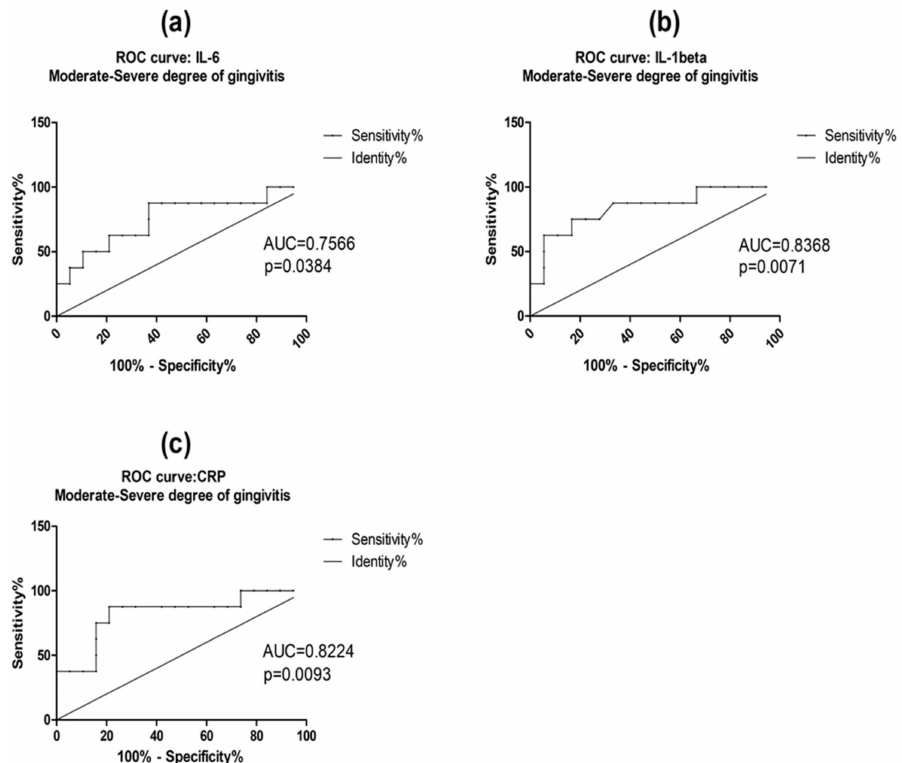
Figure 4. ROC curves of ( a ) IL-6, ( b ) IL-1 β , and ( c ) CRP as potential diagnostic biomarkers for differentiating children with a moderate degree of PIG from children with a severe degree of PIG.